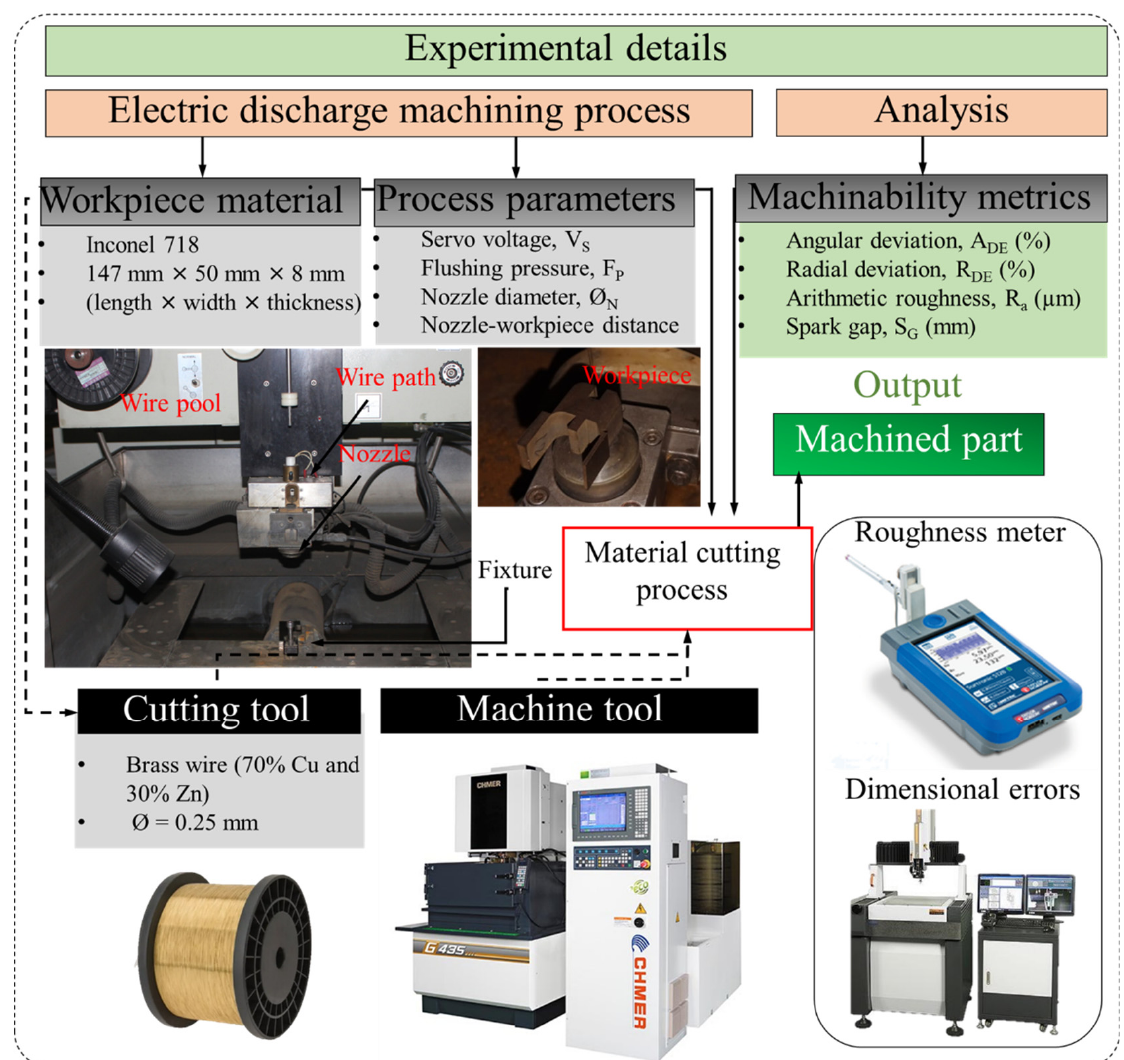
Figure 3. Experimental details and framework.